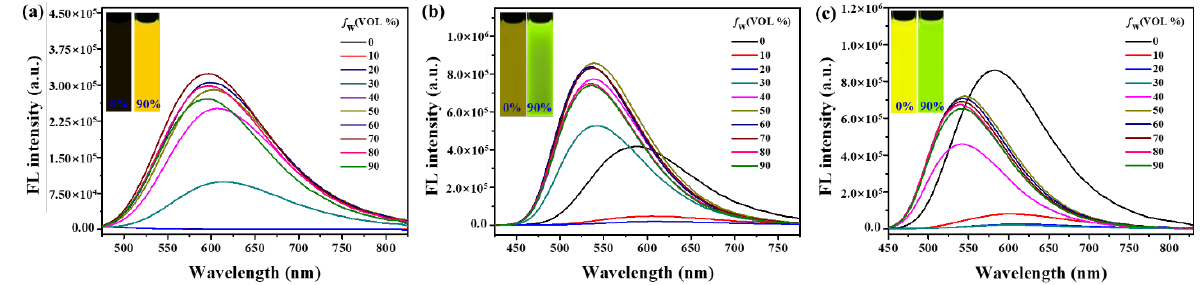
Figure 1. Fluorescence spectra of the dilute solutions of luminogens 1–3 ( a – c ) in DMF-H 2 O mixtures with various water contents. Inset: fluorescence images ( f w ; excited wavelength: 365 nm, 20 mm).